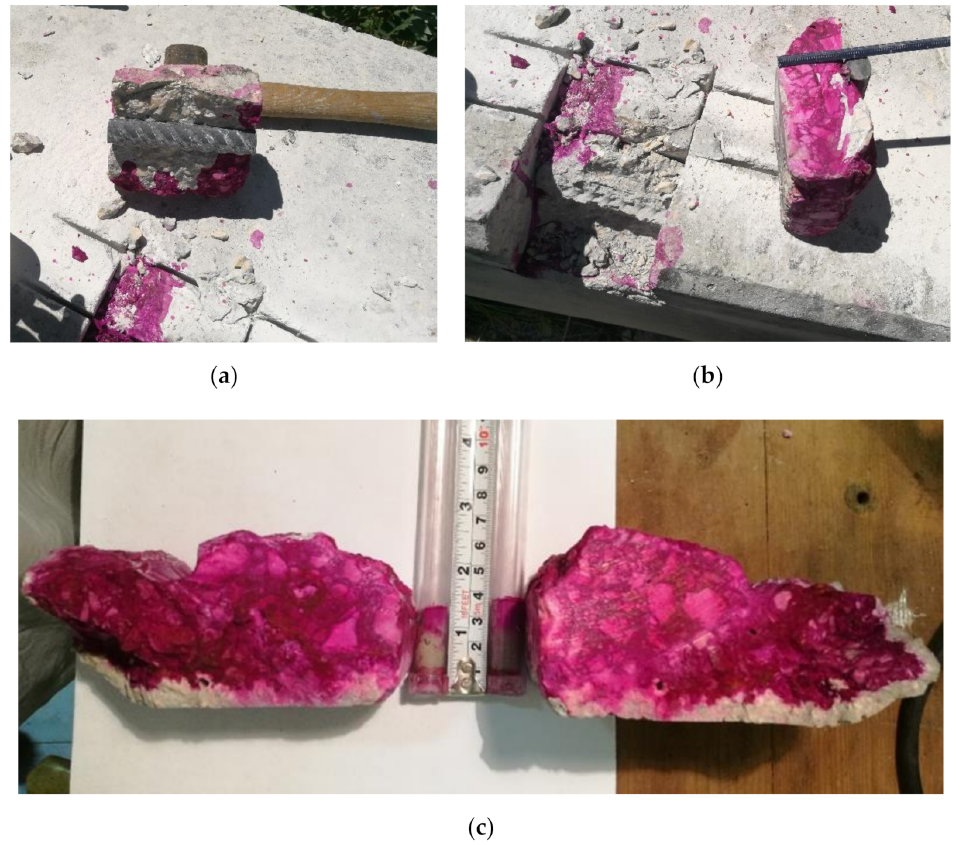
Figure 9. Additional neutralization assays in column C. ( a ) bottom view of specimen C3; ( b ) lateral view and extraction site; ( c ) neutralization fronts after phenolphthalein addition over the two split fragments of specimen C3 and across the drilling powder in test